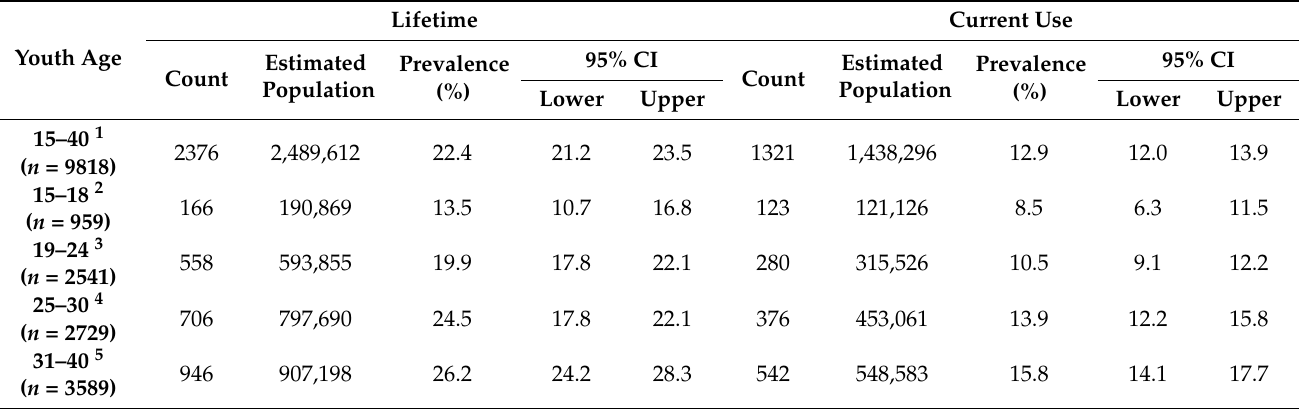
Table 2. Prevalence of substance (tobacco and alcohol) and drug use among the